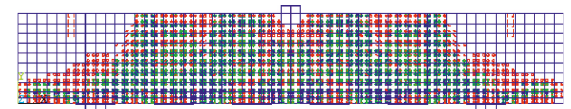
Figure 13: FE crack patterns at failure load for beam A2.5RC10/10.